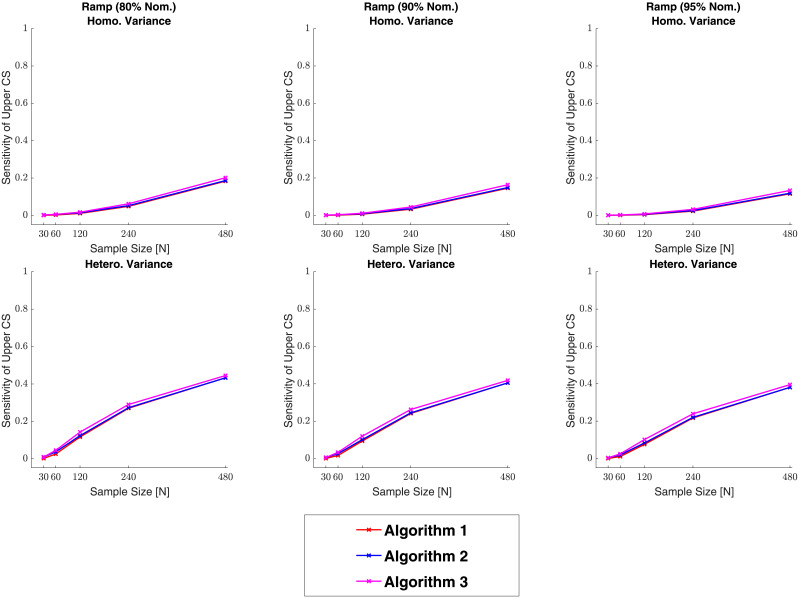
Sensitivity results for the ramp signal, with homogeneous (top row) and heterogeneous (bottom row) Gaussian noise structures.